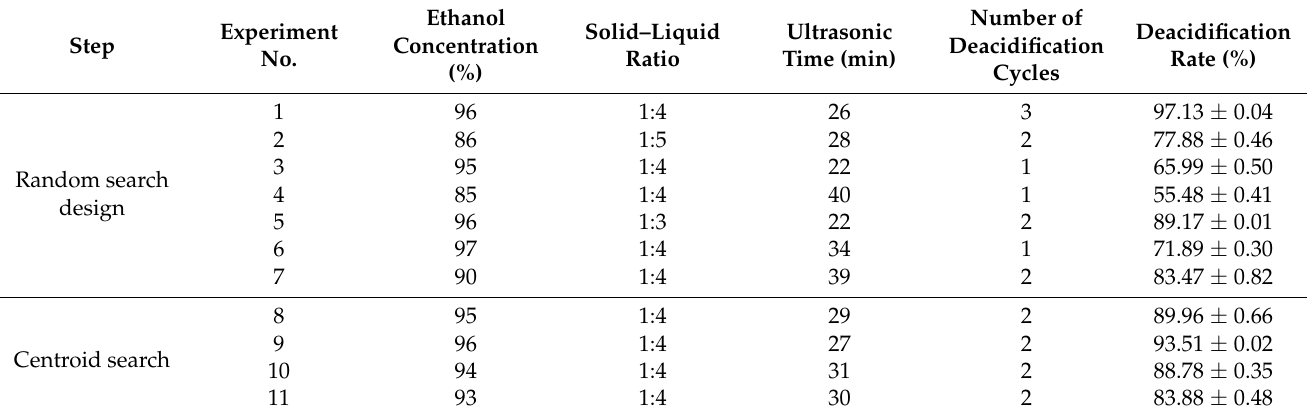
Table 2. Results of the second round of